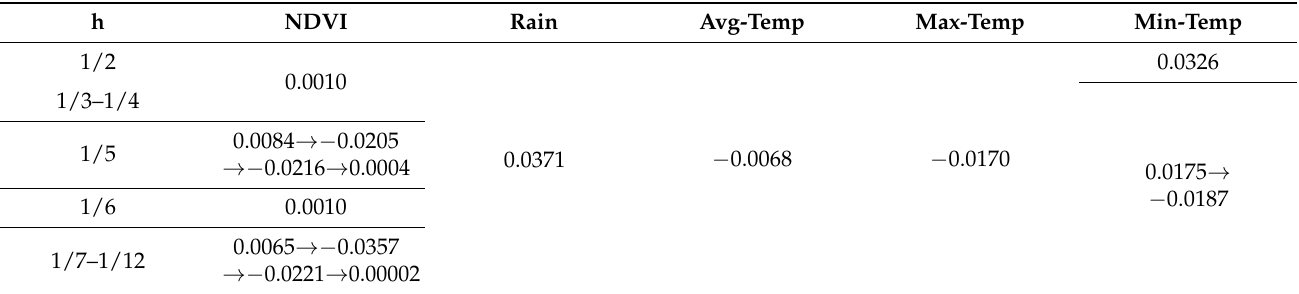
Table 3. BFAST slope results for NDVI, rainfall (Rain), average temperature (Avg-Temp), maximum temperature (Max- Temp), and minimum temperature (Min-Temp) in Taiwan, with varied h